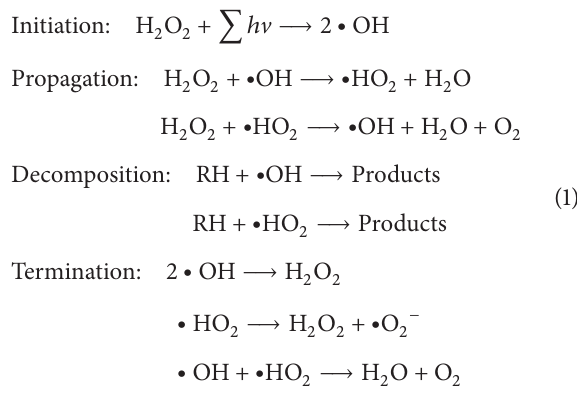
Figure 8: The influence of hydrogen peroxide concentration on the degradation of phenol.